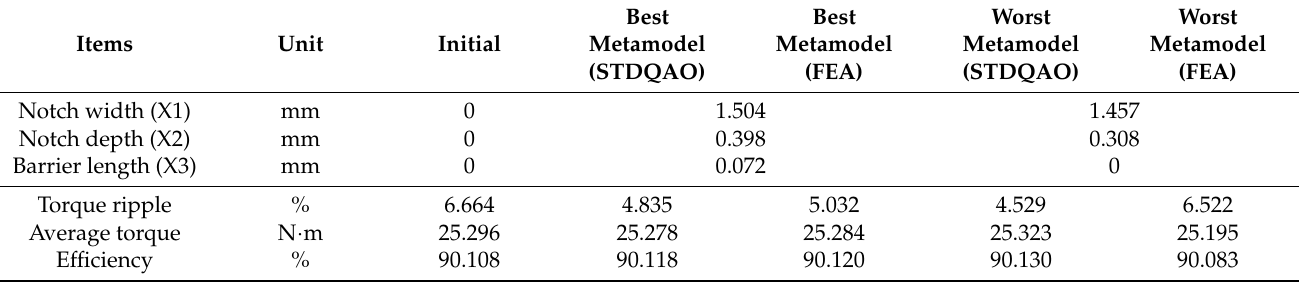
Table 7. Comparison of the optimal design results for the best and worst